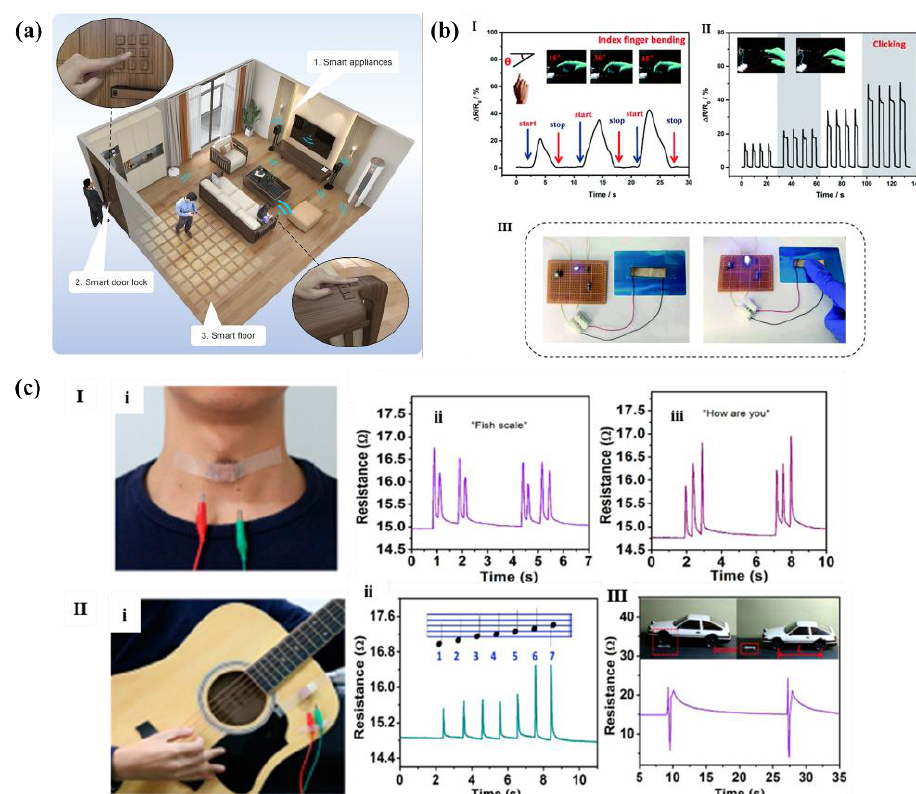
Figure 16. Micro structed flexible pressure sensors used in ( a ) smart home [121], ( b ) human-computer interaction [122], ( c ) speech recognition ( I , II ), and speed detection ( III ) [112].